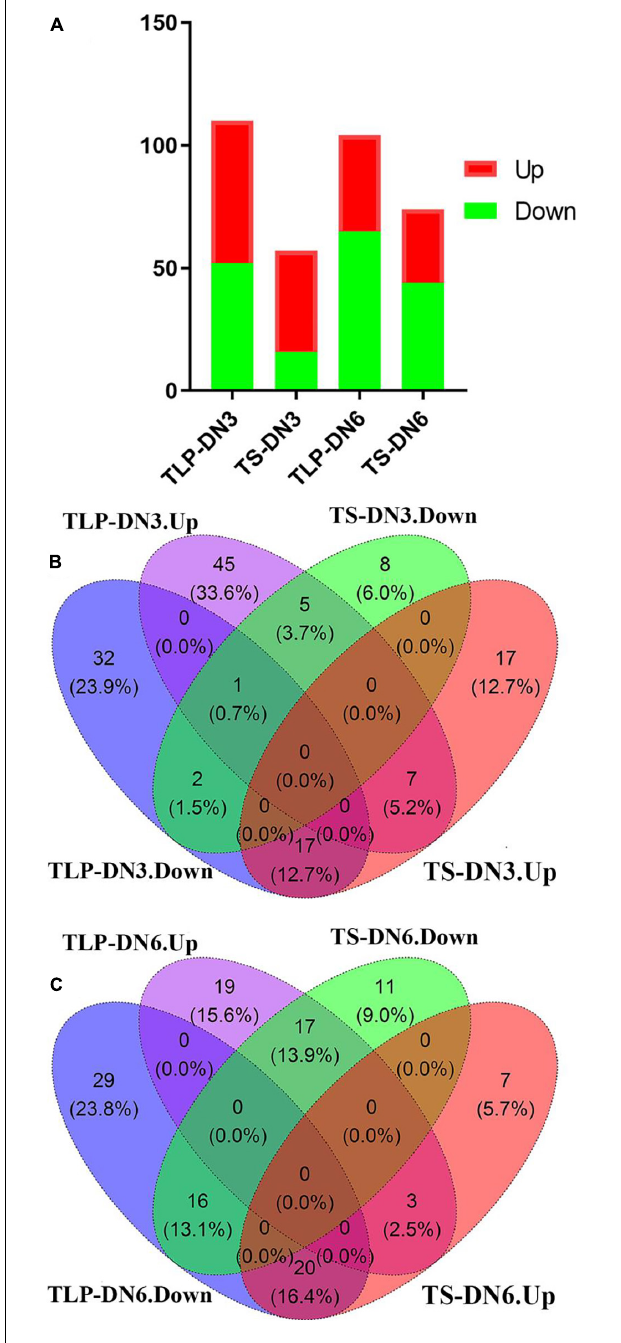
FIGURE 4 | The number of up-regulated and down-regulated DEMs in two different growth stages (A) . Venn diagram showed the overlaps of the DEMs in DN3 (B) . Venn diagram showed the overlaps of the DEMs in DN6 (C)